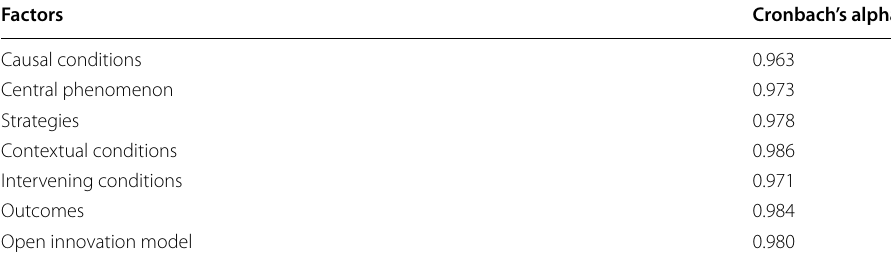
Table 5 Cronbach’s alpha of the factors and total score